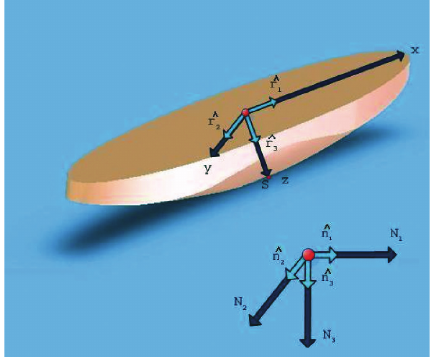
Figure 1: Rattleback’s shape and its axes of coordinates.